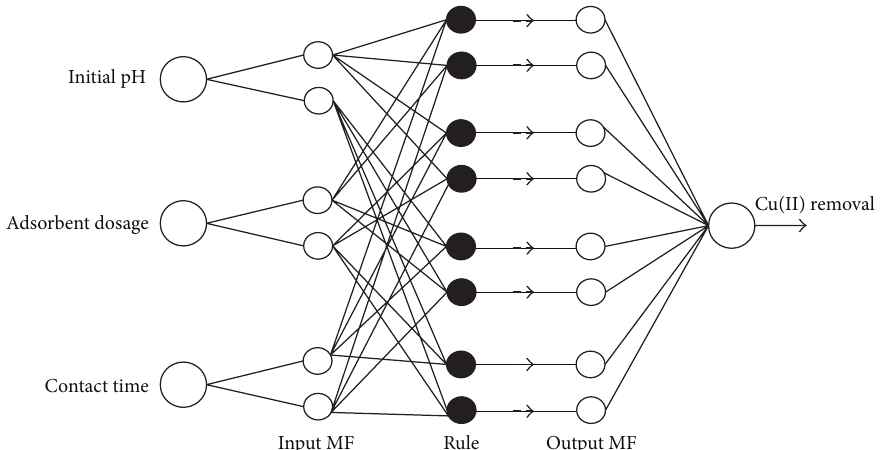
Figure 2: Proposed ANFIS structure for Cu(II) removal system.